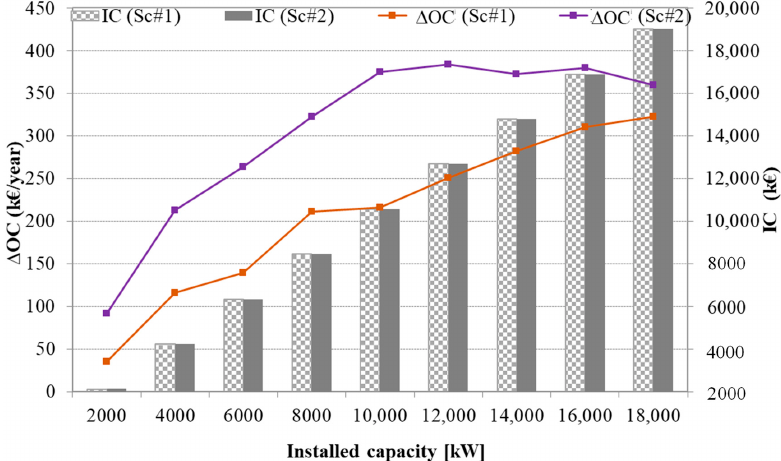
Figure 7. Investment cost and the di ff erence between operating cost of CS and PS ( ∆ OC ) in both scenarios as function of installed capacity.